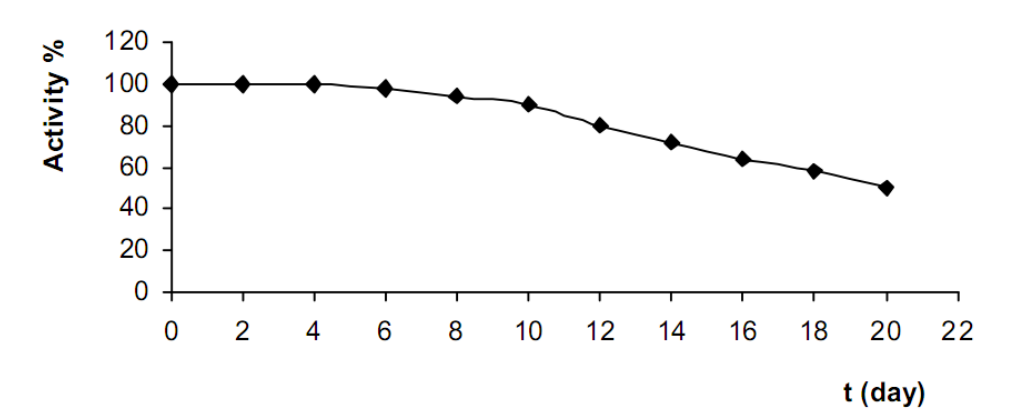
Figure 5. Storage stability of the biosensor (phosphate buffer; pH 7.0, 50 mM, T: 25 °C, detection: DPV, scan rate: 15 mV/s, 2.0 × 10 −4 M